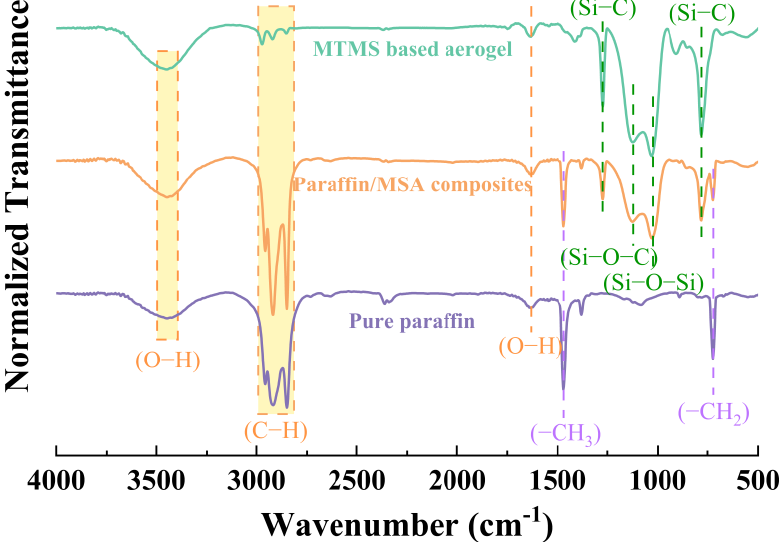
Figure 6. FTIR spectra of the MSA, paraffin and paraffin/MSA composites.